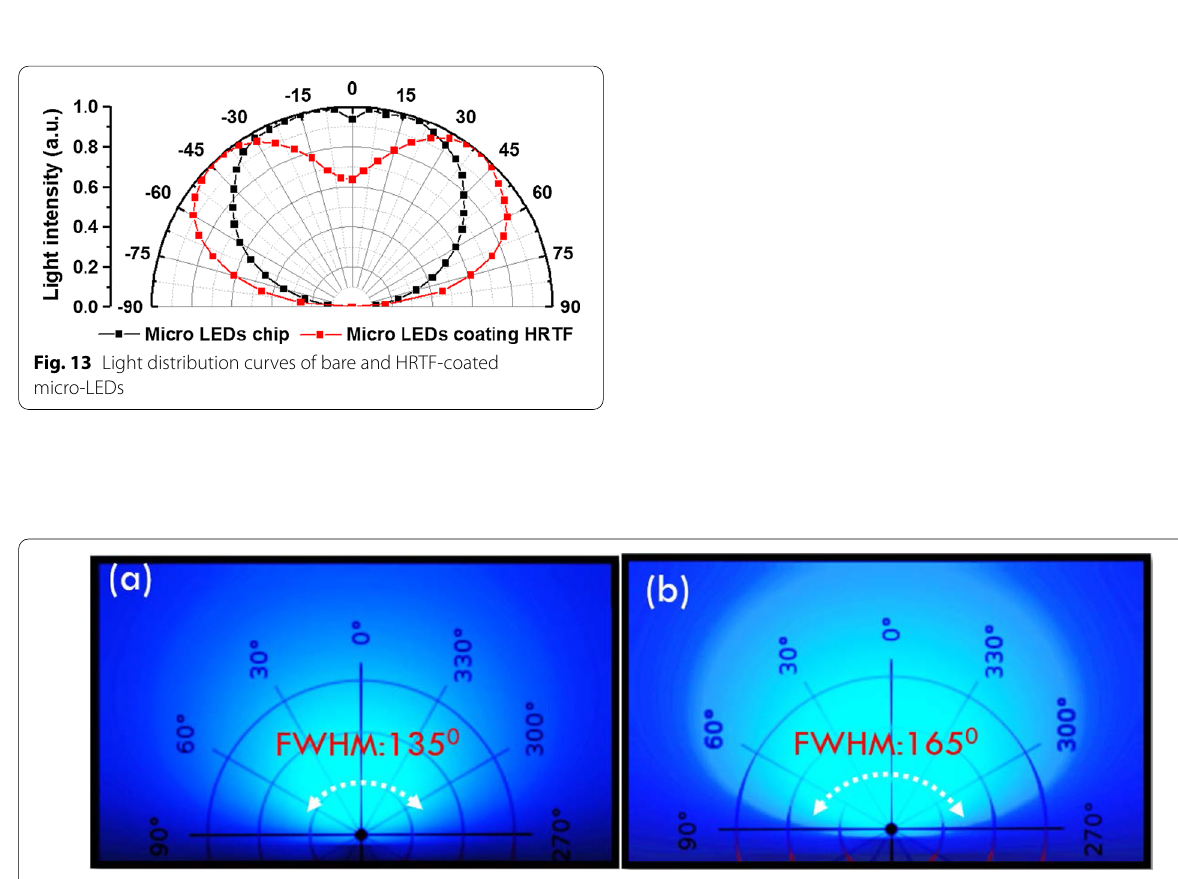
Fig. 14 Schematic of the luminous distributions of a bare and b HRTF‑coated